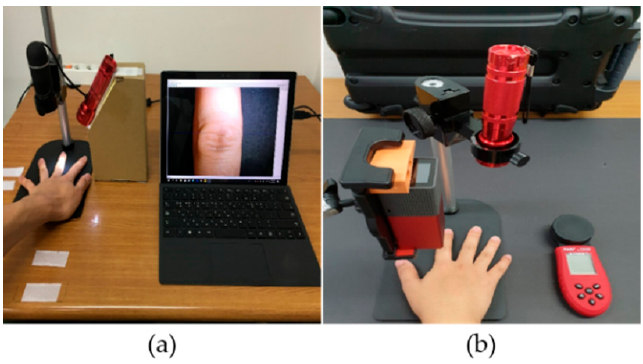
Figure 8. Experimental setup: ( a ) setup of training image acquisition; ( b ) setup for capturing test images from a Lytro camera with various illumination conditions.